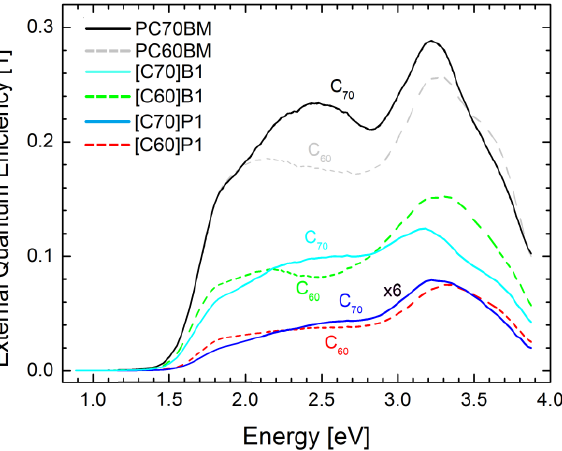
Figure 9. Comparison of EQE spectra of fullerene derivatives based on C 60 and C 70 fullerenes.